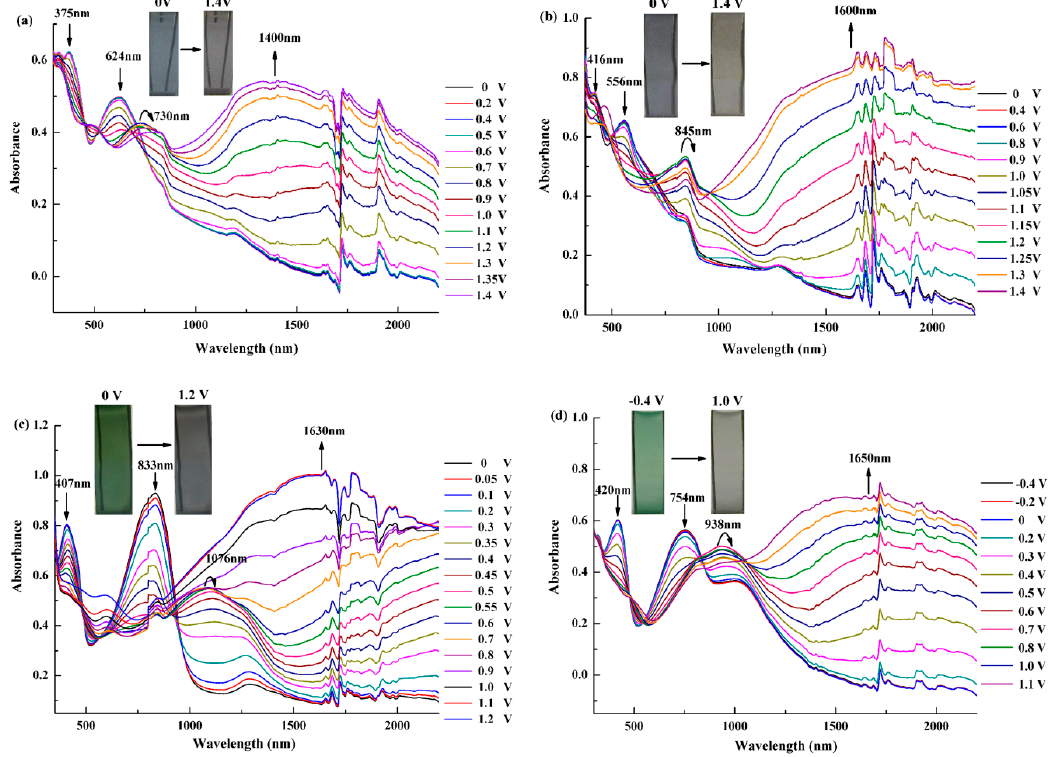
Figure 9. Spectroelectrochemical spectra of the polymers for p-doping process: ( a ) P1; ( b ) P2; ( c ) P3; and ( d )